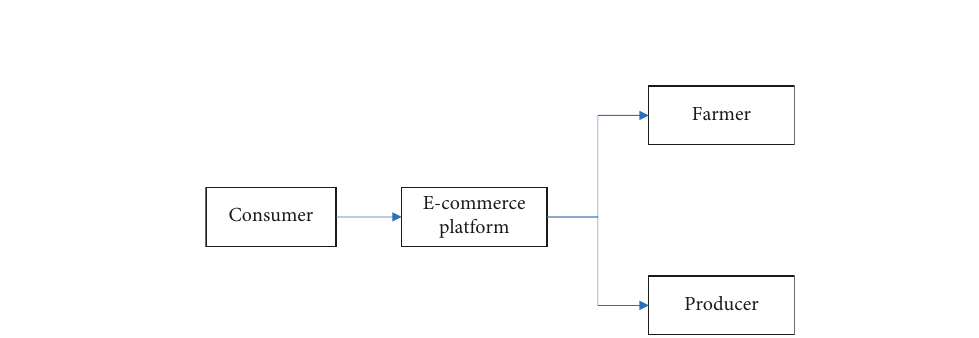
Figure 3: The main process of the A2C model.